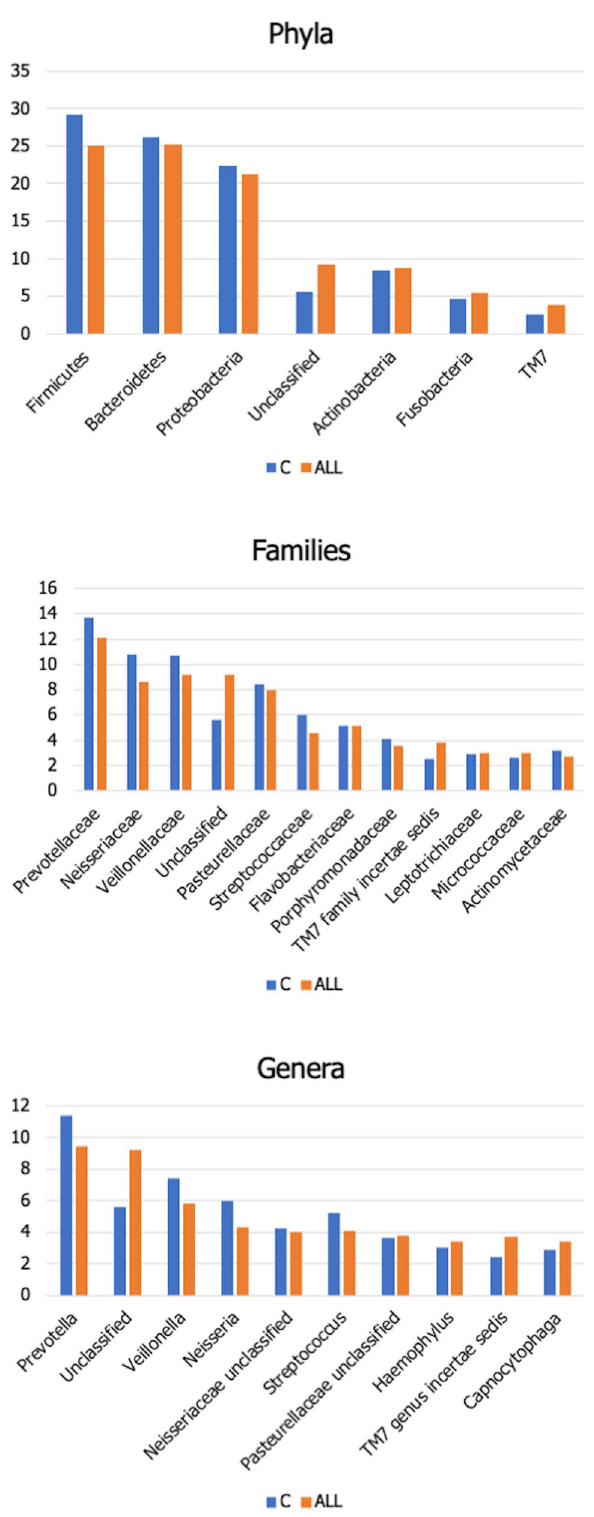
Figure 3. Taxonomic composition of the salivary microbiota in allergic (ALL) patients compared to sex- and age-matched healthy controls (C). Average relative abundance of the most represented phyla, families and genera identified in the two groups. Only taxa whose relative abundance is > 3% in at least one group are